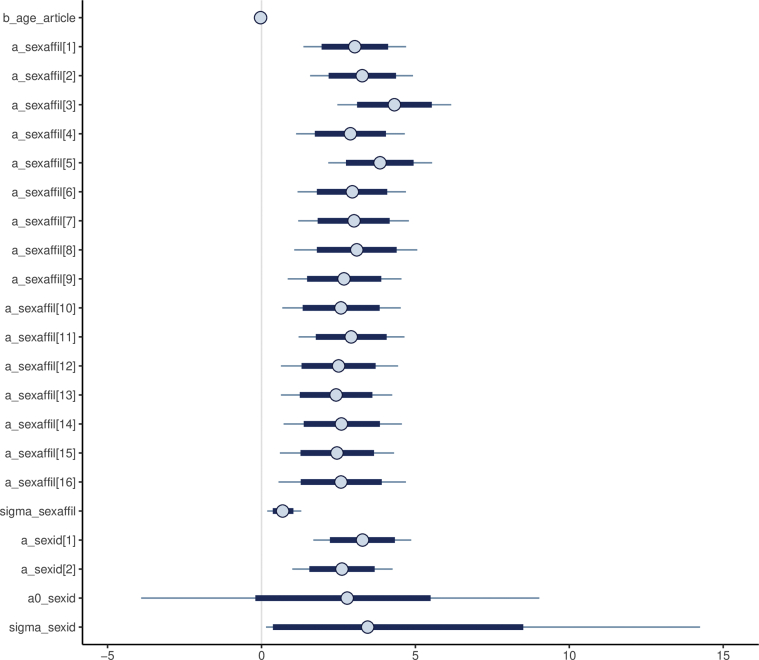
The αsexaffil and αsexid variables in the Article model.